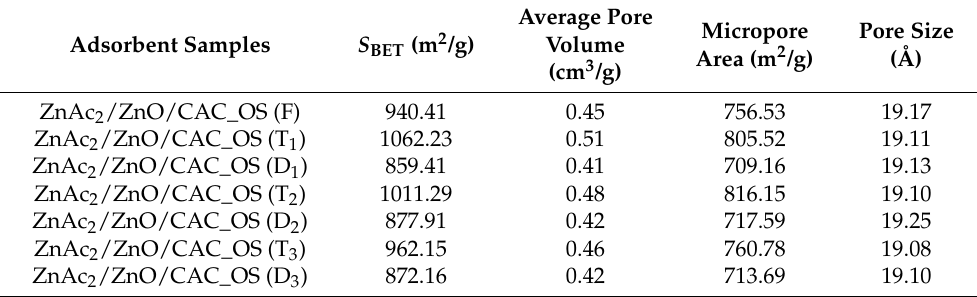
Table 6. Porous properties for ZnAc 2 /ZnO/CAC_OS through three H 2 S adsorption–desorption